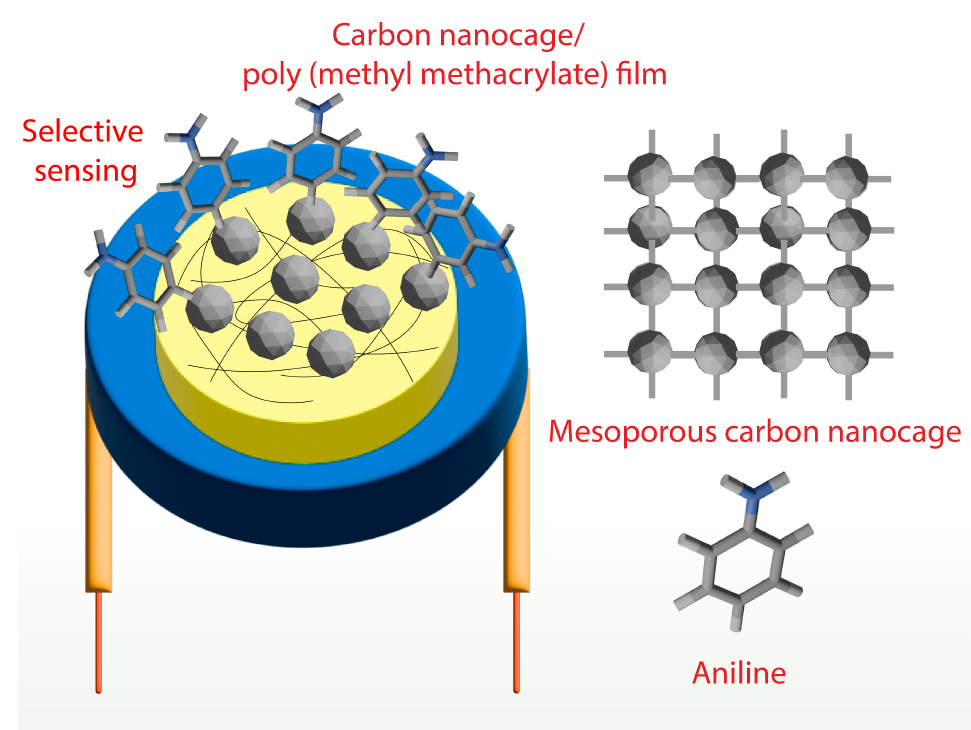
Figure 3. Highly sensitive mesoporous carbon nanocage-based sensor for the detection of aniline.